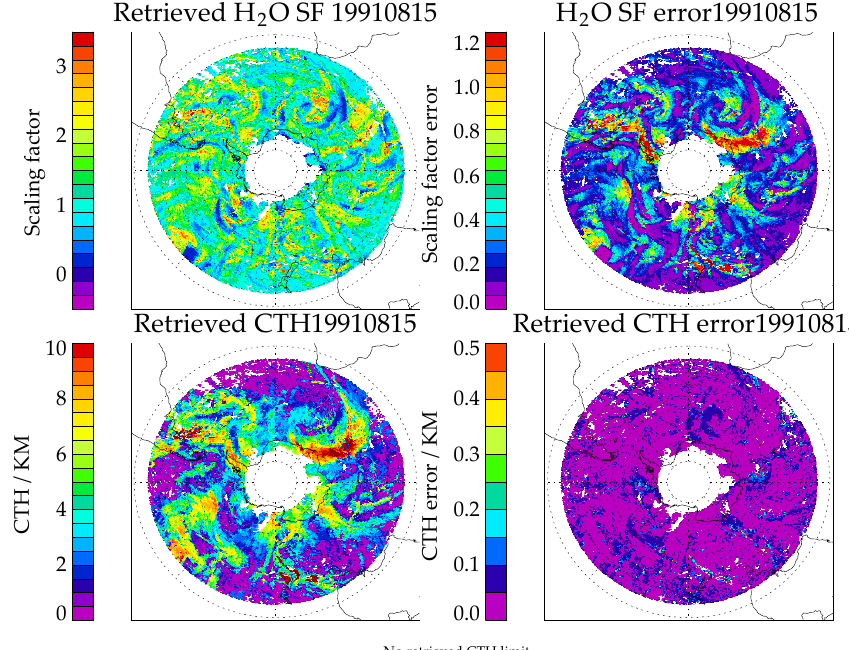
Figure 7. The top left and top right show the retrieved water vapour scaling factor and its error from the column retrieval. The bottom left and right show the equivalent for the retrieved cloud top